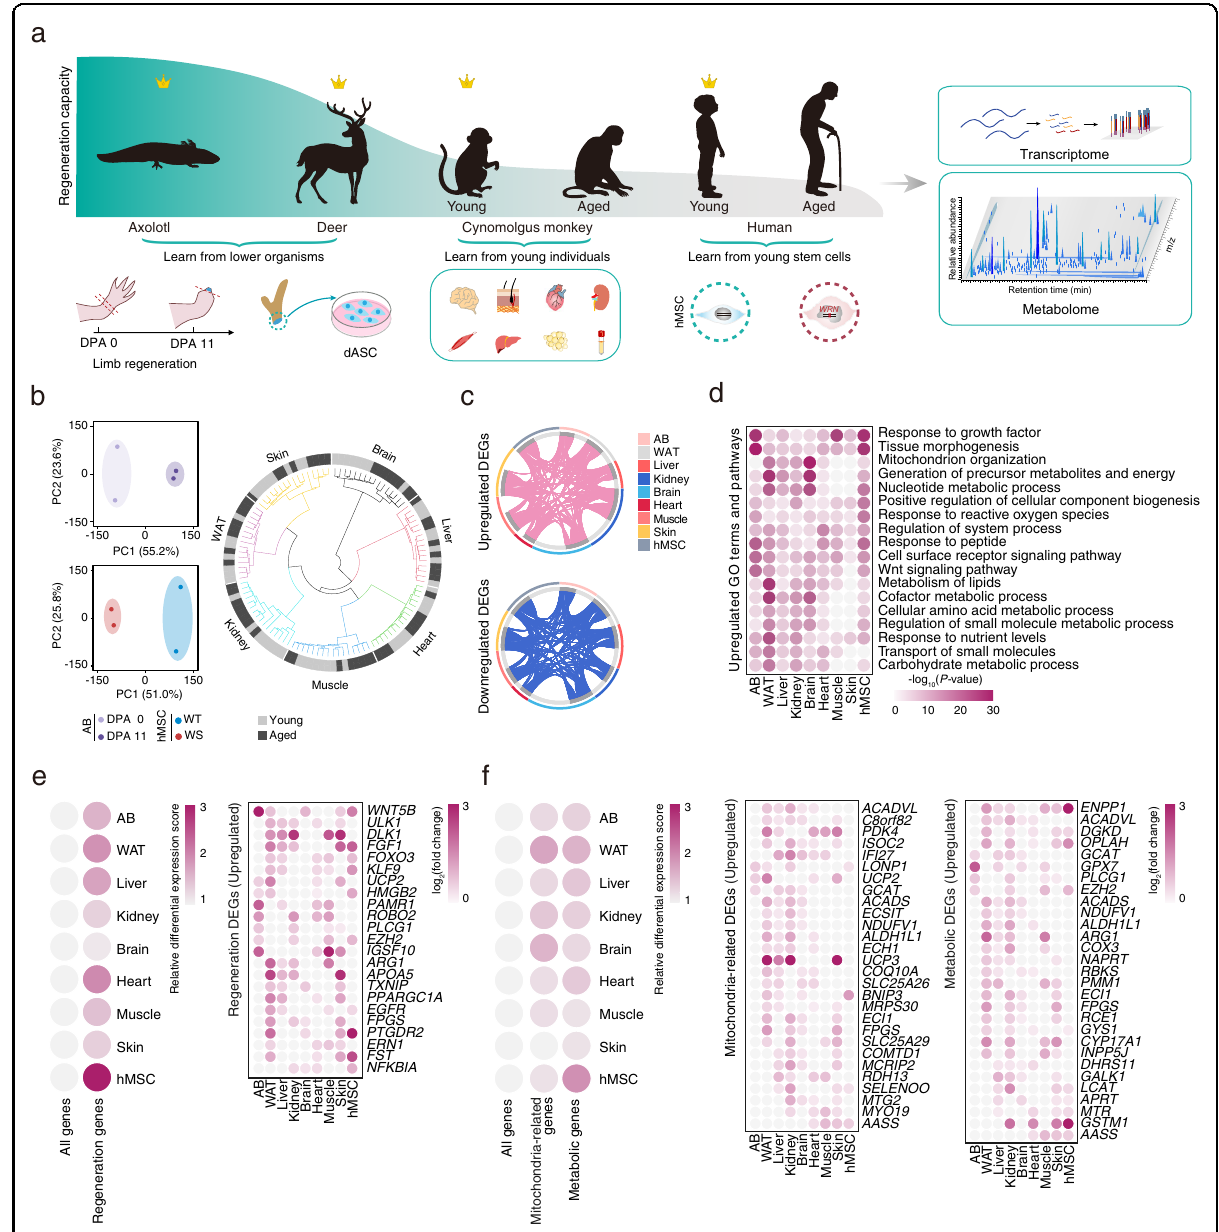
Fig. 1 Cross-species transcriptomic features associated with differential regenerative capacities. a Flowchart of experimental design for obtaining transcriptome and metabolome data from samples with differential regenerative capacities: axolotl blastema (AB) at DPA 0 and DPA 11, deer antler stem cells (dASCs), tissues from young and aged non-human primates (NHPs), and young and aged hMSCs. b Left, PCA analysis of the transcriptome data of AB at DPA 0 and DPA 11 (top) and WT and WS hMSCs (bottom). Right, tree plot showing the Euclidean distance for transcriptome data of young and aged NHP tissues. c Circos plots showing the overlap of upregulated (top) and downregulated (bottom) DEGs in AB at DPA 11, young tissues, and young hMSCs. d Bubble plot showing the enriched GO terms and pathways for upregulated DEGs in AB at DPA 11, young tissues, and young hMSCs. The color key from white to amaranth indicates low to high – log 10 ( P -value). e Left, bubble plot showing the relative differential expression (DE) score for all genes and regeneration genes in AB at DPA 11, young tissues, and young hMSCs. The color key from white to amaranth indicates the relative DE scores from low to high. Right, bubble plot showing the convergently upregulated regeneration DEGs in AB at DPA 11, young tissues, and young hMSCs. The color key from white to amaranth indicates log 2 (fold change) values of DEGs from low to high. Genes convergently upregulated in at least four tissues/cells with high regenerative capacity were shown. f Left, bubble plot showing the relative DE score for all genes, mitochondria-related genes or metabolic genes in AB at DPA 11, young tissues, and young hMSCs. Middle, bubble plot showing the convergently upregulated mitochondria-related DEGs in AB at DPA 11, young tissues, and young hMSCs. Right, bubble plot showing the convergently upregulated metabolic DEGs in AB at DPA 11, young tissues, and young hMSCs. The color key from white to amaranth indicates DE scores (left) or log 2 (fold change) values of DEGs (middle and right) from low to high. Genes convergently upregulated in at least four tissues/cells with higher regenerative capacity were